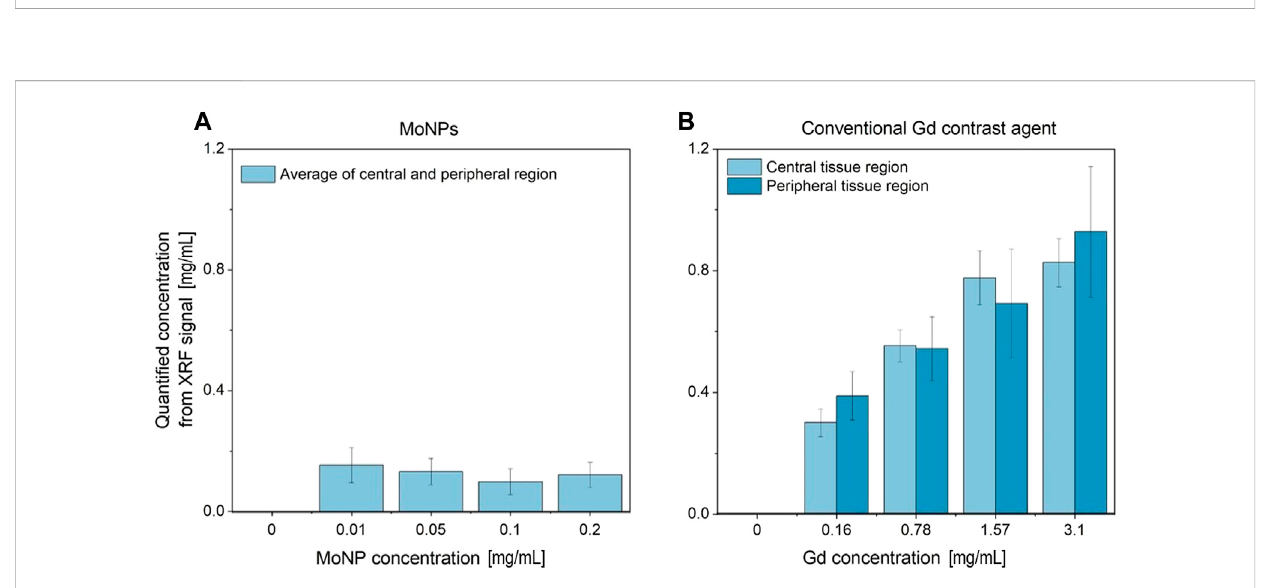
FIGURE 14 (A) Average MoNP and (B) Gd uptake concentration sampled (local-contrast-based threshold segmentation) from the reconstructed slices in the central and peripheral (adjacent to cell crown) ROI in the tissue